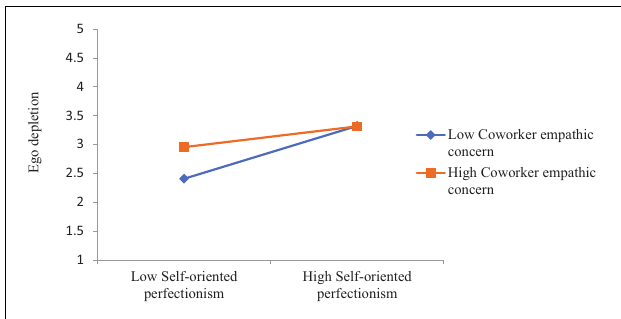
FIGURE 2 | Interactive effect of self-oriented perfectionism and coworker empathic concern on ego depletion.